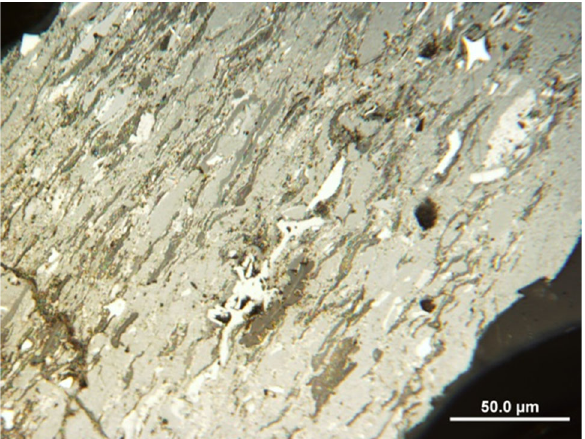
Fig. 3 Collodetrinite with sporinite and whitish inertinite macerals: fusinite, macrinite, inertodetrinite and micrinite